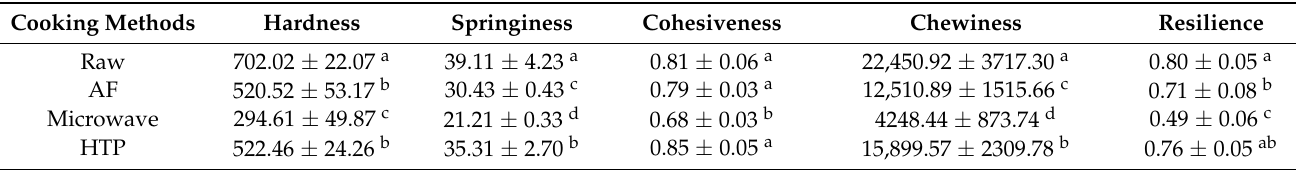
Table 2. Texture parameters of UP under different cooking